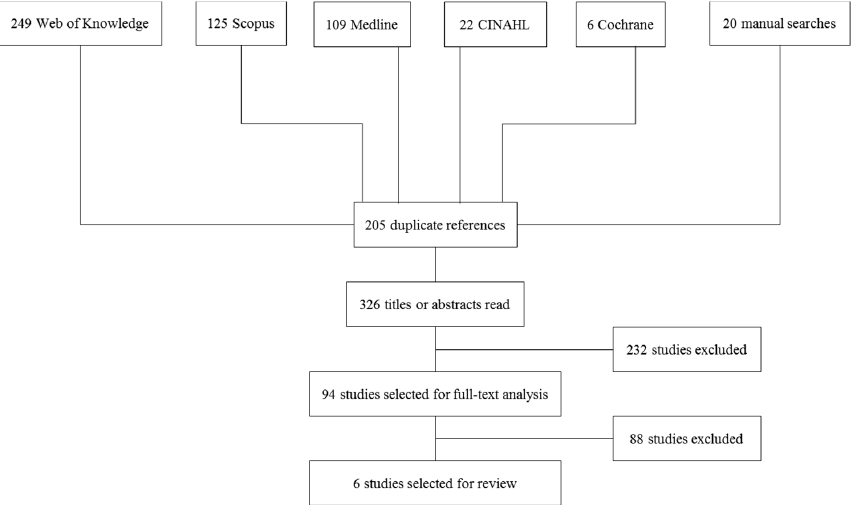
Figure 1. Flowchart of selection process of included studies.